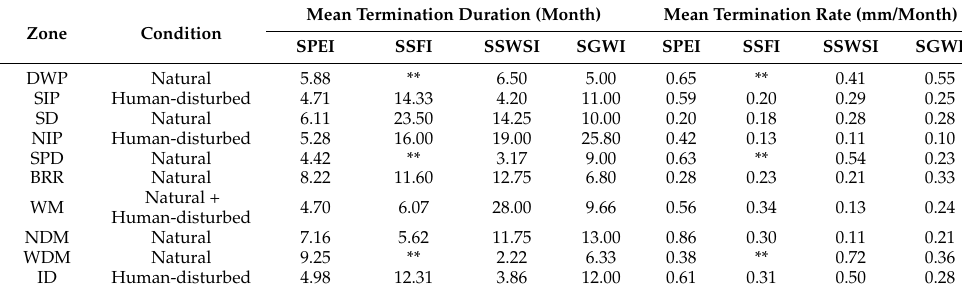
Table 2. Drought termination characteristics in different